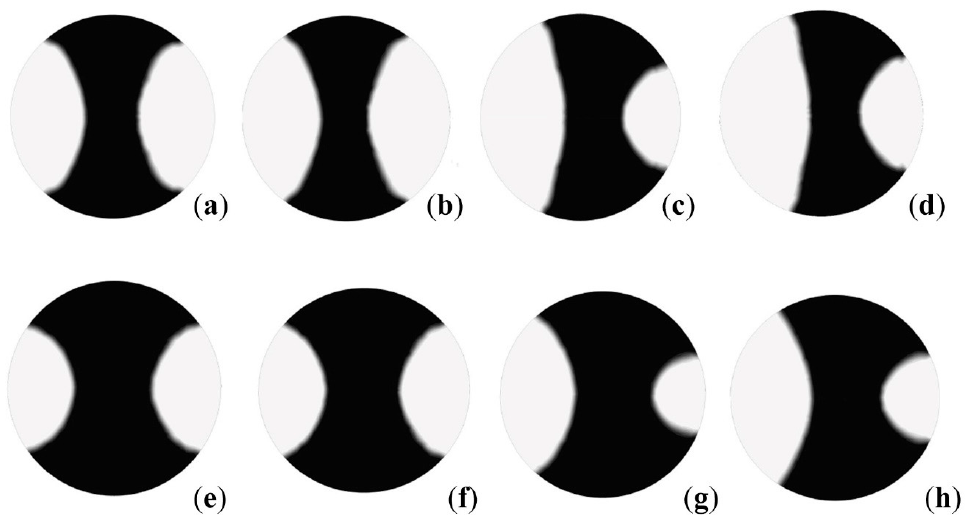
Figure 7. Time-averaged prediction of slag eyes at different operating conditions obtained with the numerical model. ( a ) through ( h ) are the experiments described in Table 2. The cases presented in this study are in the same order as in the experimental study of Jardón-Pérez et al. [15].